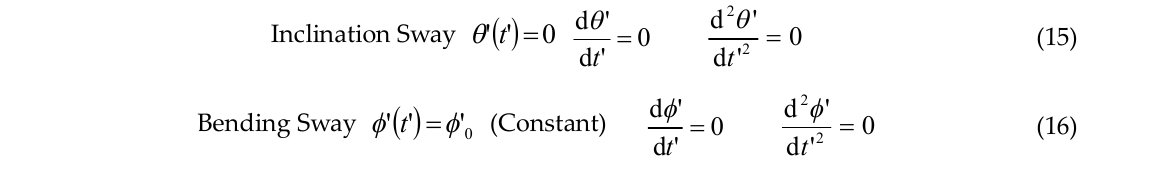
Figure 3. Development of Inclination Sway   '' t  ,   normalized form, in case of Q ’ = 37.3 (example: 28 bpm in Waltz, with body proportion